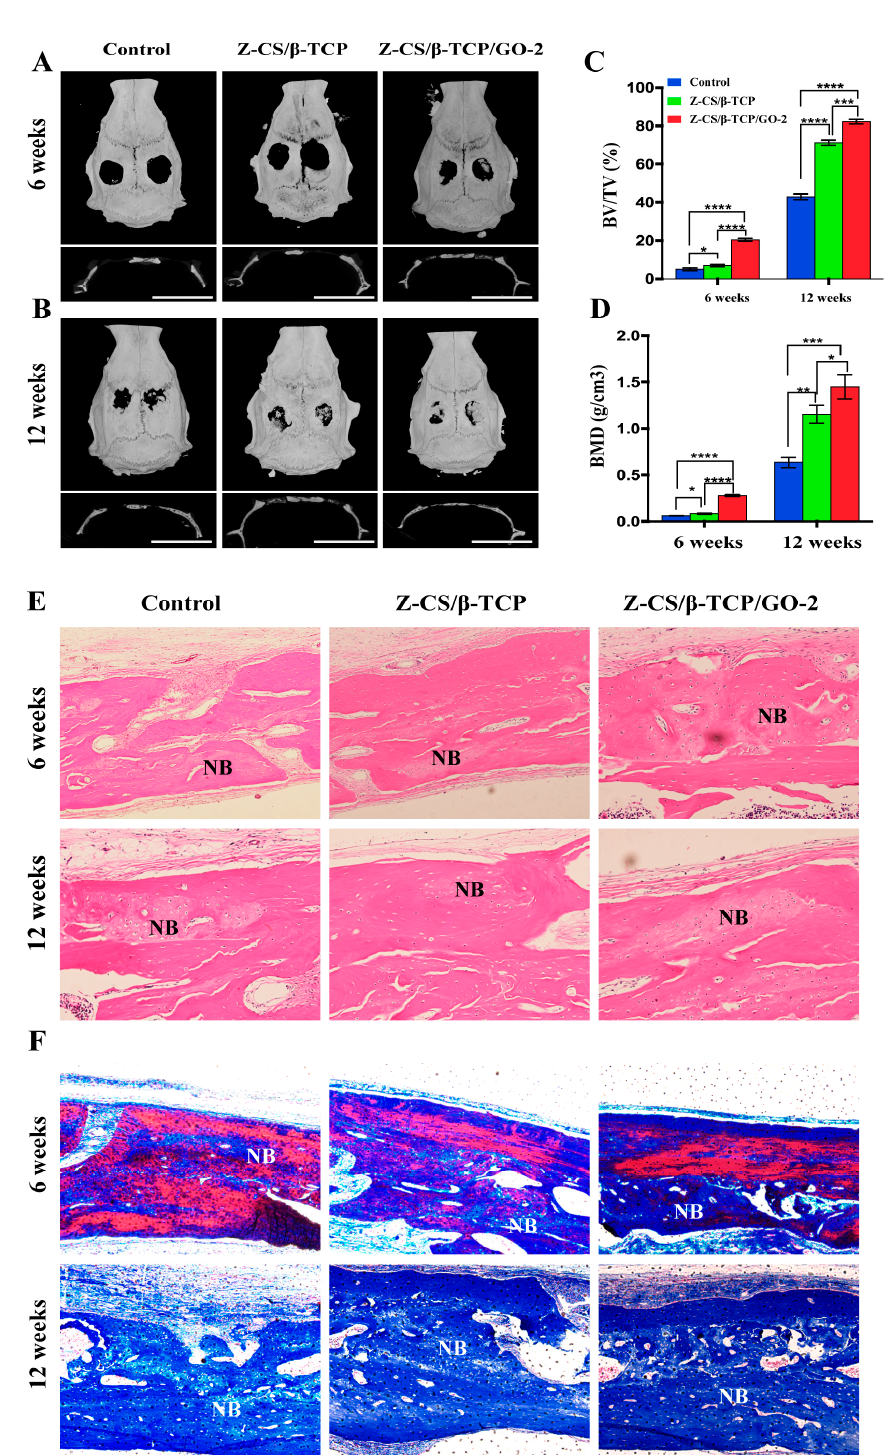
Figure 6. Osteogenic differentiation in vivo. Bone repairing model by Micro-CT at ( A ) six weeks (scale bars, 10 mm) and ( B ) twelve weeks post implantation (scale bars, 20 mm). ( C ) Quantitative comparison of bone mineral density (BMD) and ( D ) bone volume to total volume (BV/TV). His- tological analysis of bone regeneration in different zwitterionic hydrogel at six and twelve weeks (* p < 0.05, ** p < 0.01, *** p < 0.001, and **** p < 0.0001). ( E ) H&E staining and ( F ) Masson’s trichrome staining showed fibrous tissues were regenerated in the control group. The newly formed bone with fibrous tissues was obvious in the Z-CS/ β -CTP group. In the Z-CS/ β -CTP/GO-2 group, a mount of new bone was observed. (NB: newly formed bone. Magnification ×